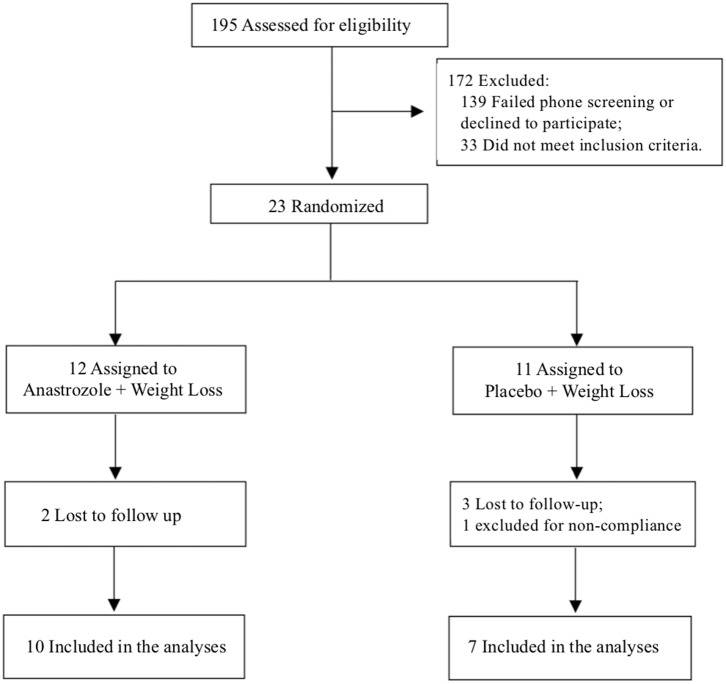
Consort diagram.